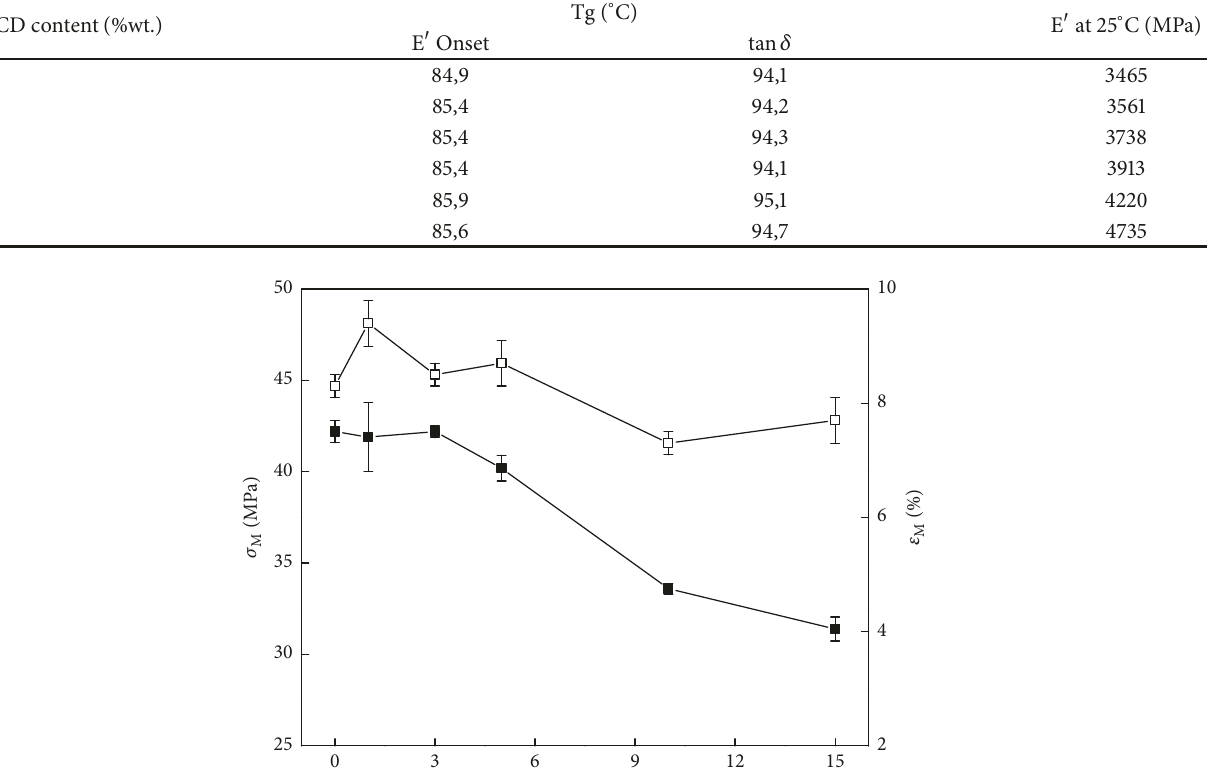
(closed symbols) and elongation at maximum stress 𝜀 M